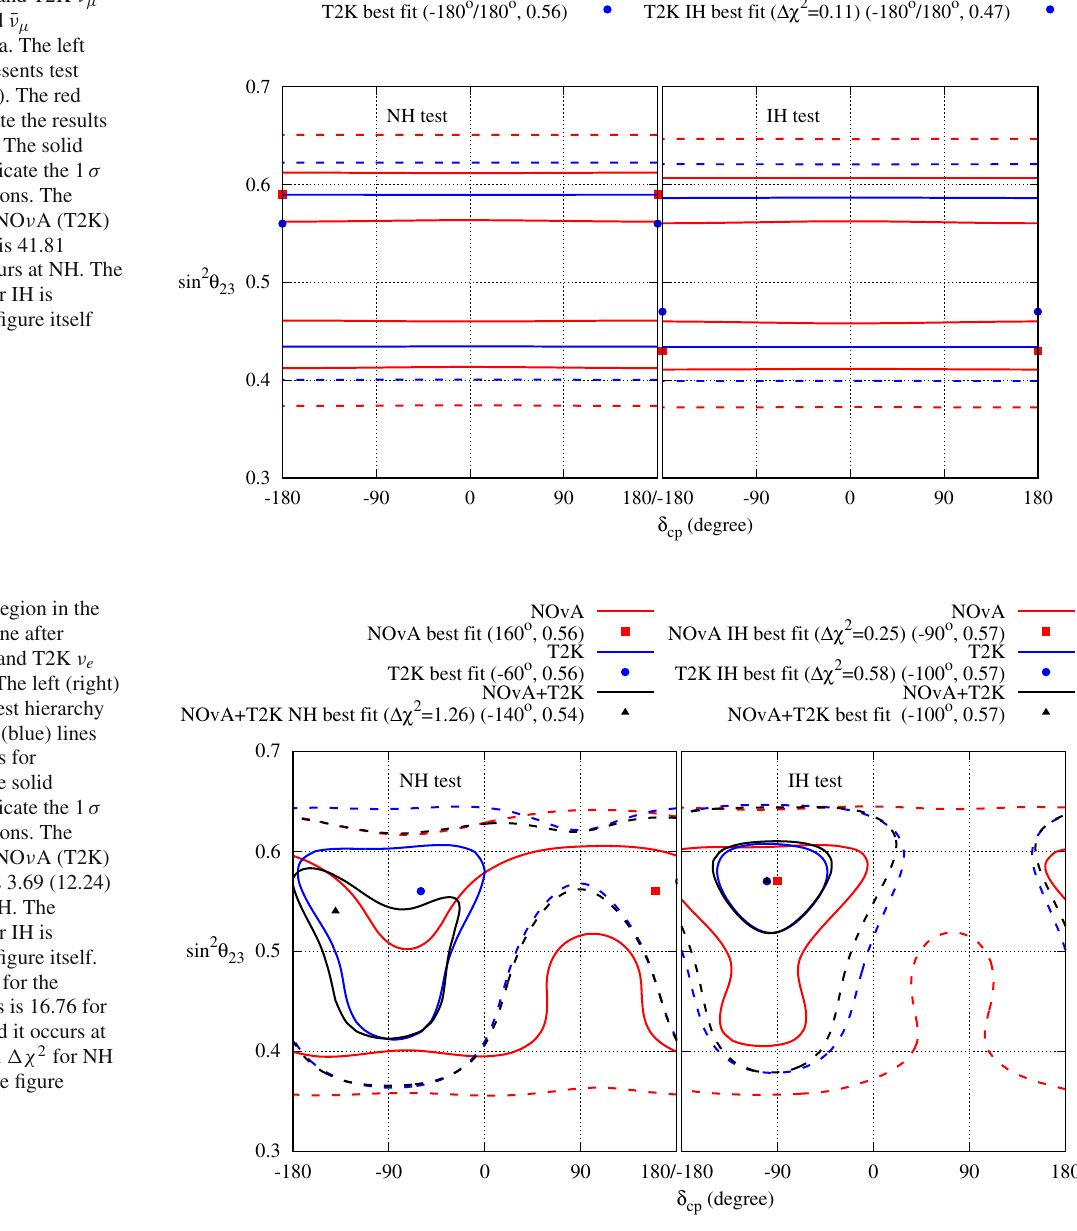
Fig. 3 Allowed region in the sin 2 θ 23 − δ CP plane after analysing NO ν A and T2K ν μ disappearance and ¯ ν μ disappearance data. The left (right) panel represents test hierarchy NH (IH). The red (blue) lines indicate the results for NO ν A (T2K). The solid (dashed) lines indicate the 1 σ (3 σ ) allowed regions. The minimum χ 2 for NO ν A (T2K) with 38 (70) bins is 41.81 (75.86) and it occurs at NH. The minimum (cid:5)χ 2 for IH is